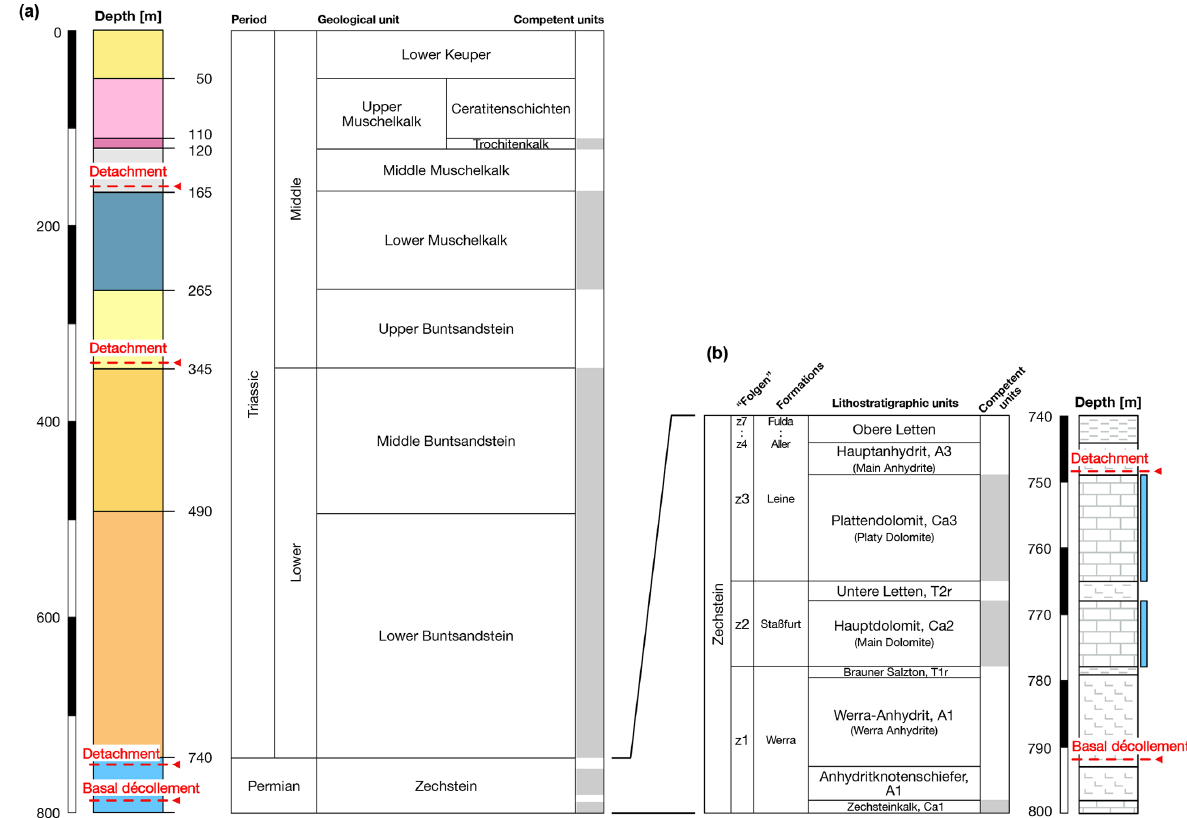
Figure 2. (a) Stratigraphic column of Zechstein and younger units in the study area. Major detachment horizons and the basal décollement are indicated. Competent horizons are highlighted in grey. (b) Detailed stratigraphic column of the Zechstein Formation. Dolomite-bearing horizons, which produce the majority of the exotic fragments, are indicated in blue. The Hauptanhydrit and the Werra–Anhydrit form the most likely detachment horizons. Zechstein nomenclature after Paul et al. (2018). The Zechstein is underlain by Rotliegend of variable thickness or deformed older